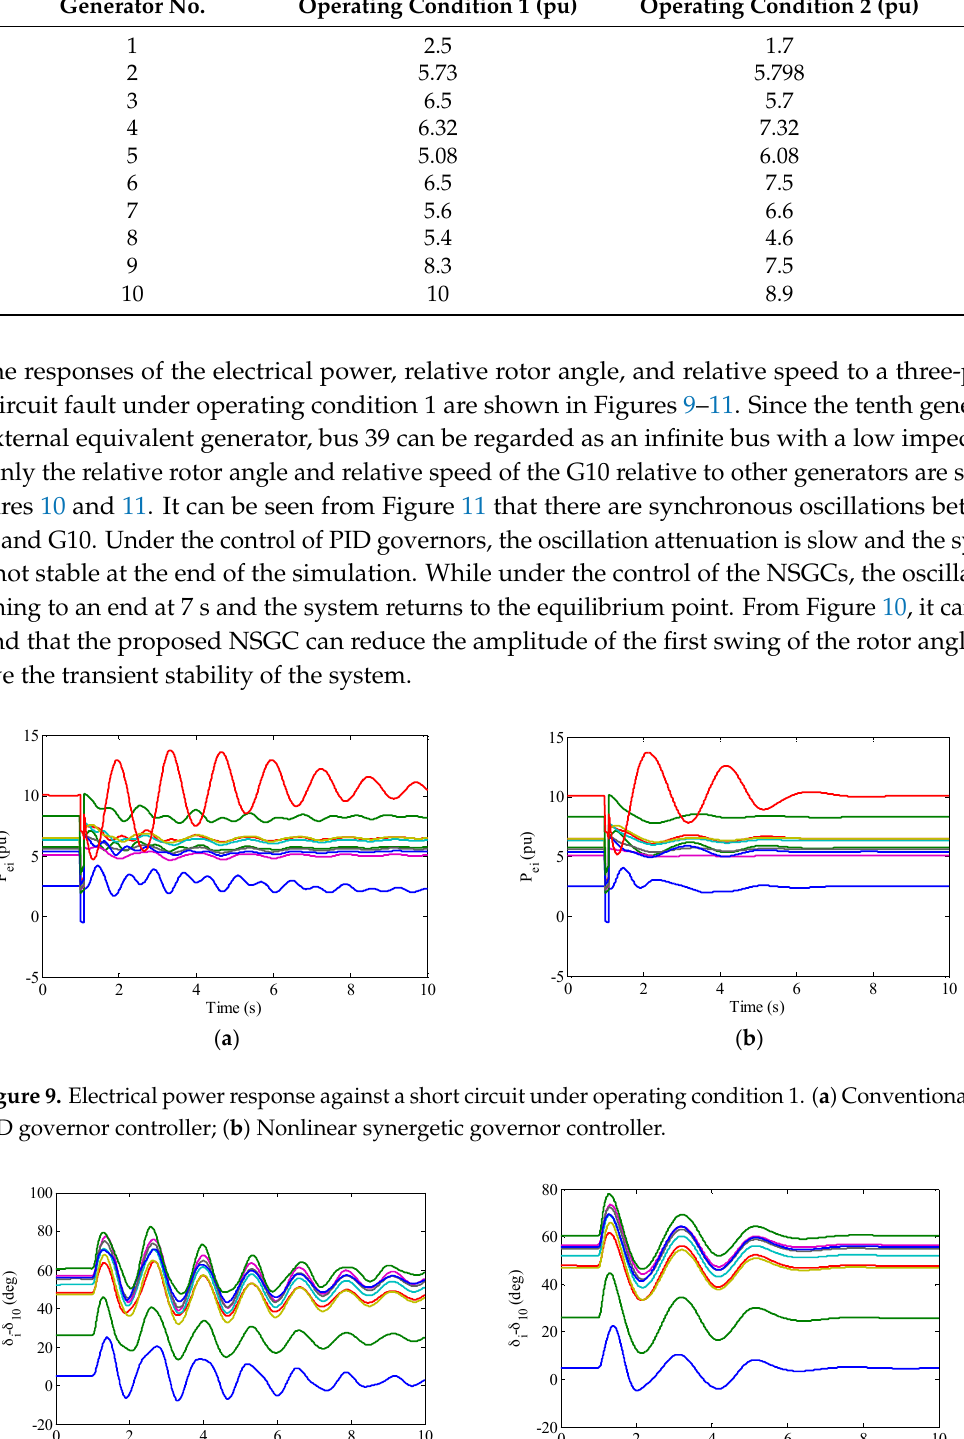
Table 1. Active power outputs of generators under different operating conditions. Generator No.